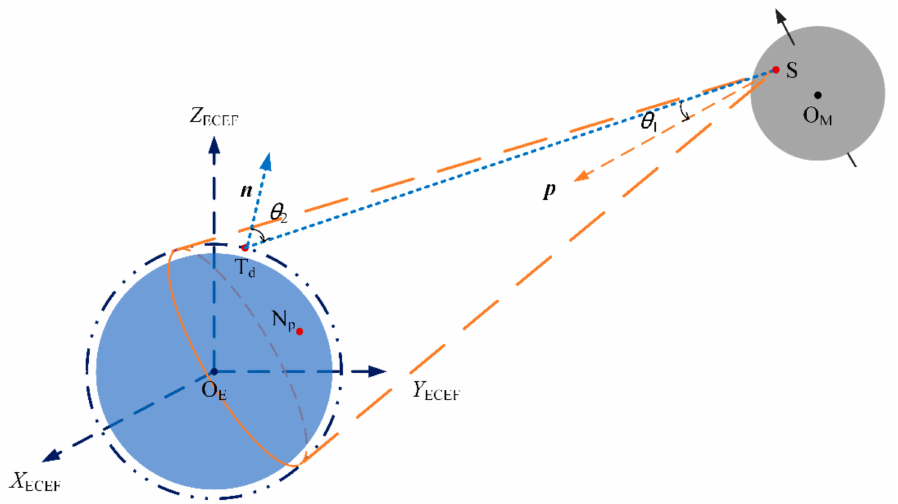
Figure 1. Illustration of the developed model’s Moon-based Earth observation geometry including core geometric parameters. The origin of the Moon and the Earth are demarcated by O M and O E , respectively, while S refers to the Moon-based sensor. Point T d , on the surface of the reference sphere (dash-dotted line) is a unit element within the observational scope, and vector n is its normal vector. The pointing vector, p , points through the Earth’s barycenter, and the intersection point between vector p and the reference level is denoted as nadir point N p . By connecting points T d and S, the angle between n and the line ST d is denoted as viewing zenith angle θ 2 , while the elevation angle ε is the complement of the viewing zenith angle, and the angle between the p and ST d is denoted as θ 1